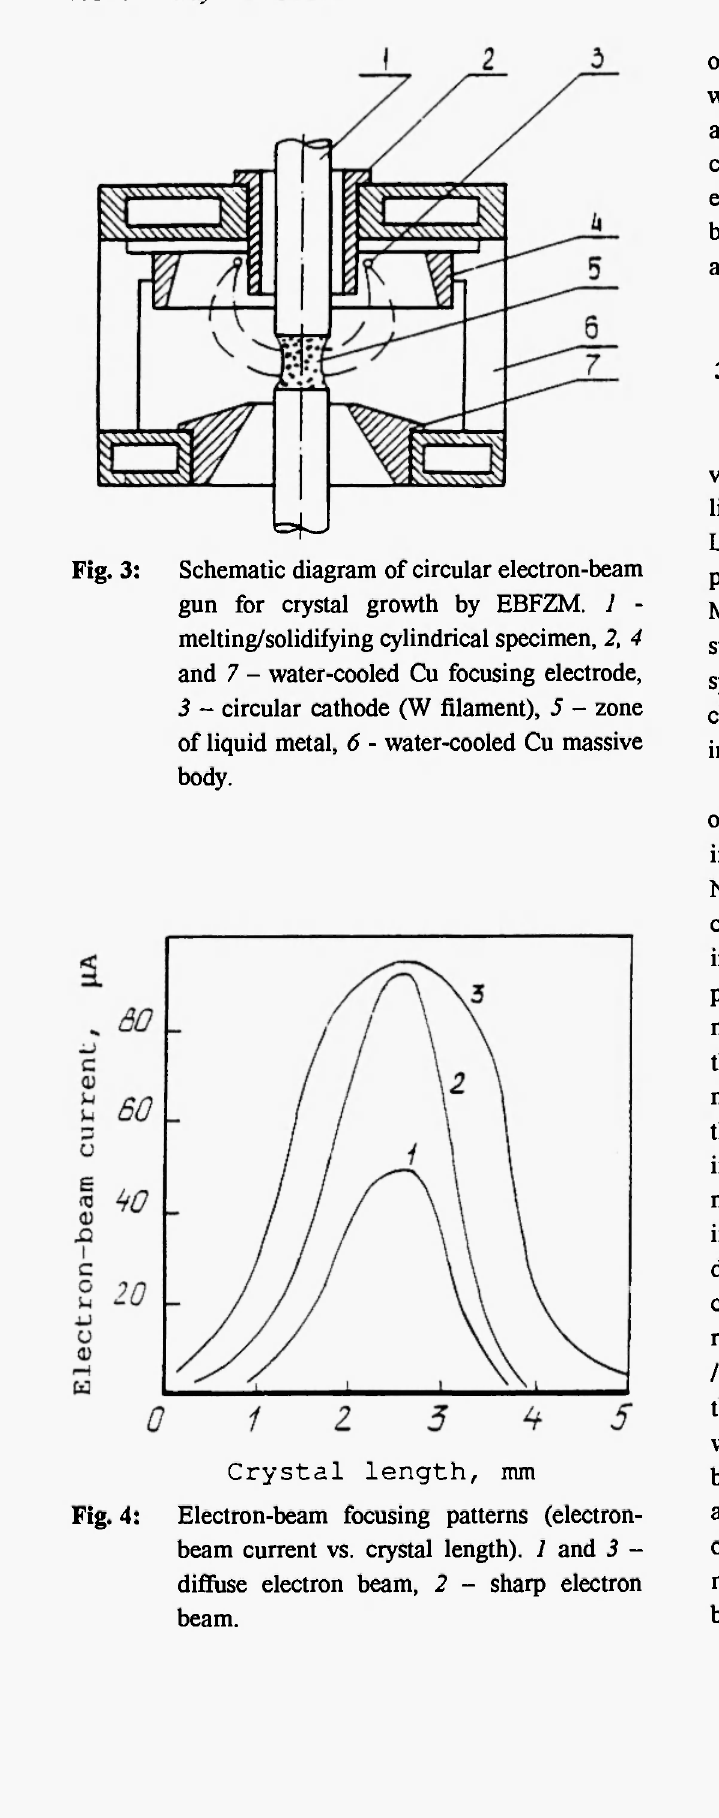
Fig. 4: Electron-beam focusing patterns (electron- beam current vs. crystal length). 1 and 3 - diffuse electron beam, 2 - sharp electron